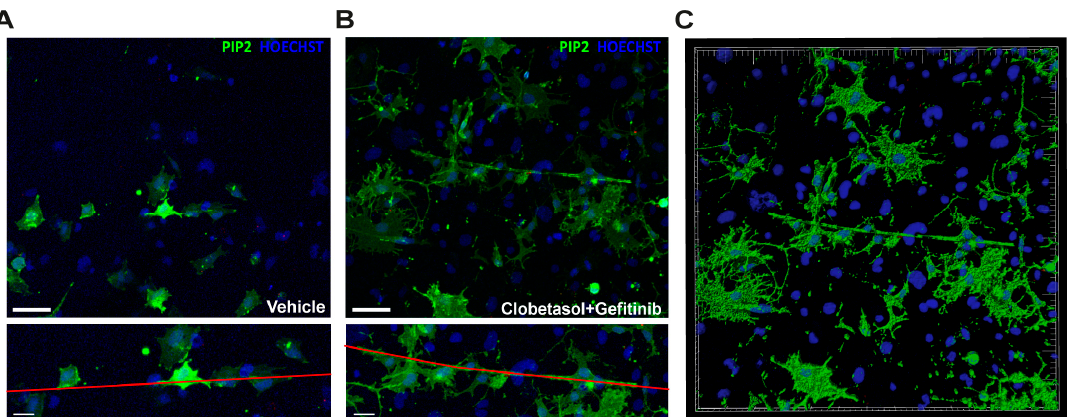
Figure 6. Clobetasol and Gefitinib promote lateral lengthening onto PS microfibers compared to vehicle-treated cells. Confocal microscopy images of PH-PLC δ -pEGFP-transfected Oli-neuM cells grown for 48 h in PS microfiber-containing growth chambers treated with (A) Vehicle (DM+ DMSO) or ( B ) 5 μ M Clobetasol and 1 μ M Gefitinib. Top ( A , B ) panels: confocal images, PIP2 (Green), Nuclei (Blue) Scale bar = 70 μ m. Lower ( A , B ) panels: detail of top images with enlargement of the cells engaging the PS microfiber. PS Microfibers are highlighted in red. Scale bar = 30 μ m. ( C ) Volume reconstruction of image in panel ( B ) , performed with Imaris software as described in Materials and Methods. Green = PIP2-containing membranes, blue = nuclei.